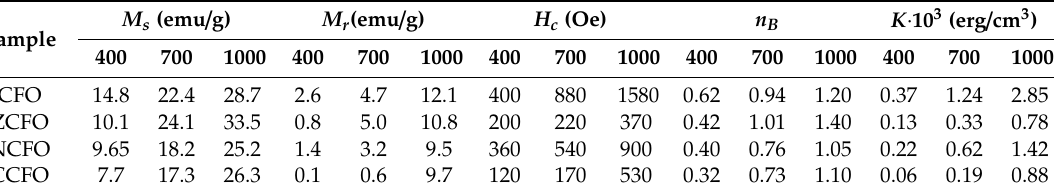
Table 2. Saturation magnetization ( M s ), remanent magnetization ( M r ), coercivity ( H c ), magnetic moments per unit cell ( n B ), and anisotropy ( K ) of CFO, ZCFO, NCFO, and CCFO annealed at 400, 700, The magnetic hysteresis loops and the magnetization derivatives ( dM / d (μ 0 H)) of CFO, ZCFO, and 1000 ◦ C. NCFO, and CCFO NCs, annealed at 400, 700, and 1000 °C are presented in Figure 5. Most of our NCs show a superparamagnetic behavior with low H c values. At 400 °C, the largest magnetizations values M s (emu / g) Sample were found for CFO, while the doping with Zn 2+ , Ni 2+ , and Cu 2+ ions depreciate the magnetic properties. At higher annealing temperatures, the introduction of the non-magnetic Zn 2+ ions in the Co-ferrite, leads to the increase of magnetization [23]. Almost all the derivatives of the hysteresis loops have small and broad peaks, indicating partially crystalline samples containing a large number of dislocations and other crystal defects. The peak height decreases with decreasing annealing temperature.